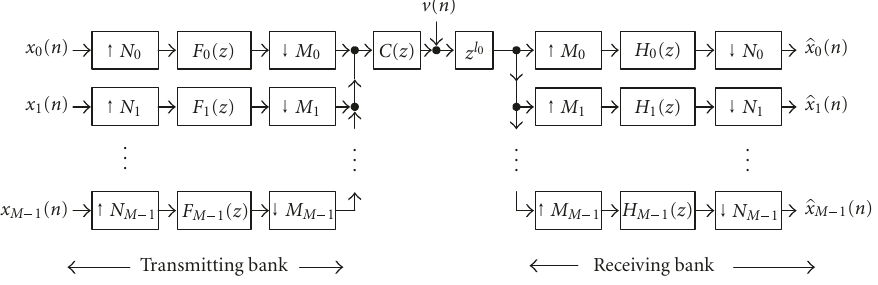
Figure 2: Nonuniform filter bank transceiver with rational sampling